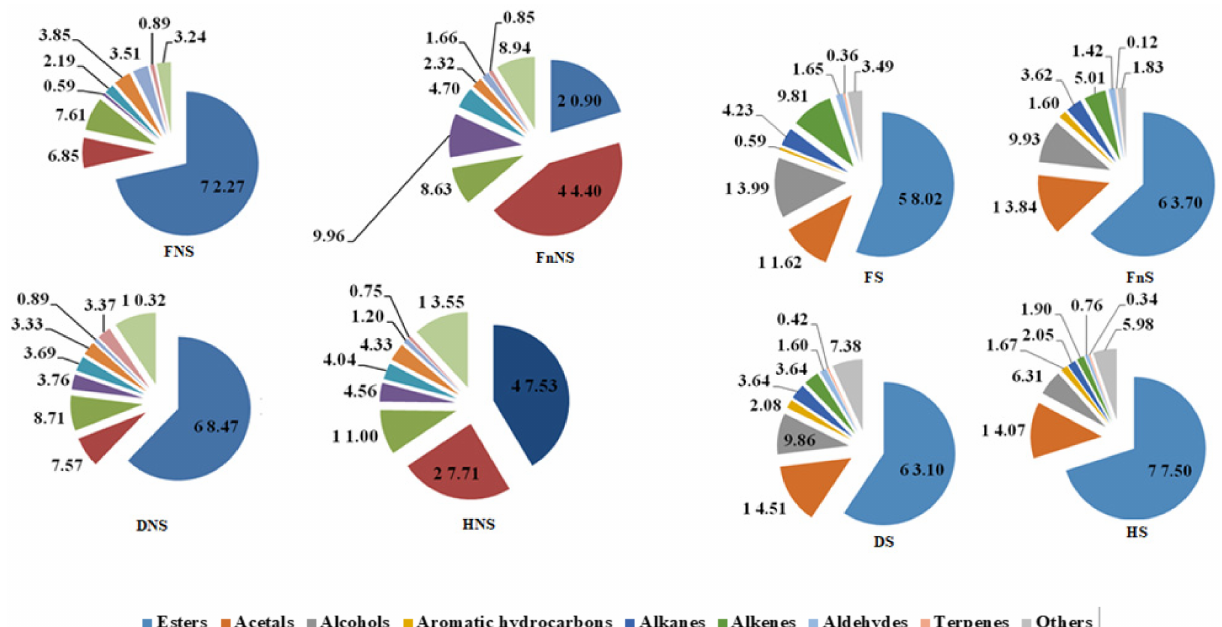
Figure 1. The content (%) of the respective groups of the volatile compounds in the liqueurs prepared from the hawthorn pseudo-fruits not-saturated with sucrose (NS) saturated with sucrose (S). Fresh (F); Frozen (Fn); Freeze-dried (D); Hot-air-dried